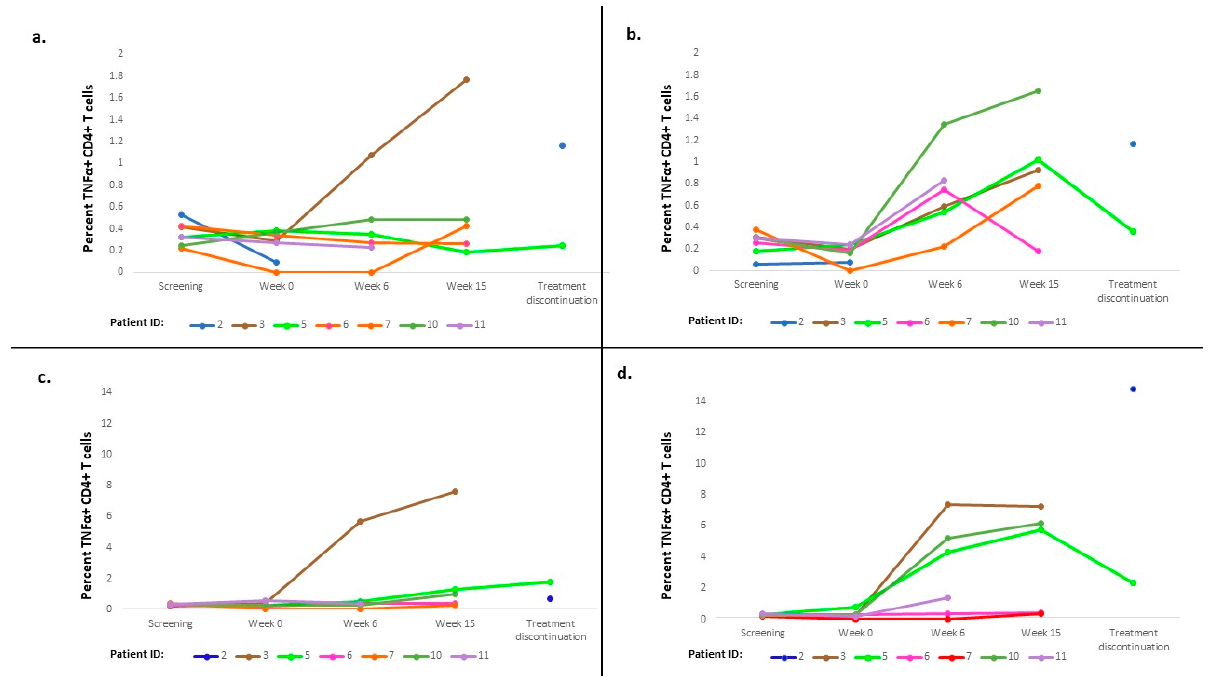
Figure 2. Cytokine responses of CD4 T cells to test peptides. ( a ) CD4 immune response against 122A in non-HLA2 patients (TNF α ); ( b ) CD4 immune response against 122A1 in non-HLA2 patients (TNF α ); ( c ) CD4 immune response against 427 L in non-HLA2 patients (TNF α ); ( d ) CD4 immune response against 331 L in non-HLA2 patients (TNF α ). HLA, human leukocyte antigen; TNF, tumor necrosis factor.